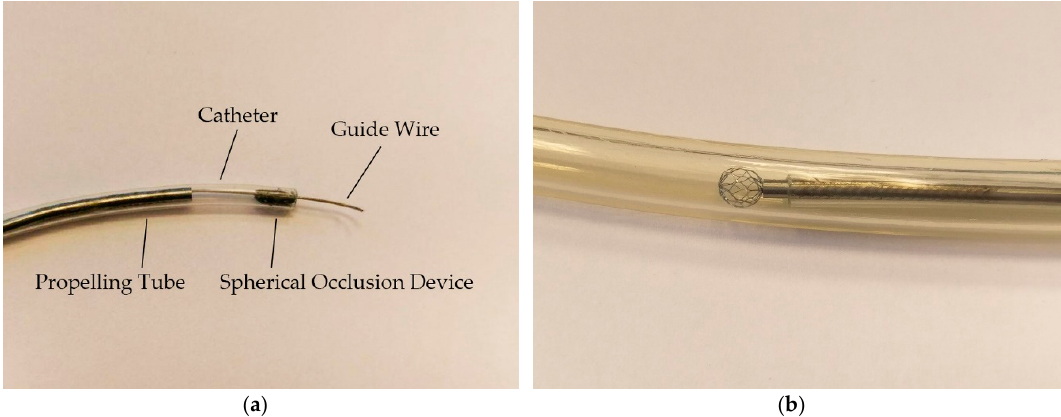
Figure 10. Deployment of spherical occlusion device. ( a ) Spherical occlusion device crimped inside catheter; ( b ) Spherical occlusion device expanded to its full sphere after deployment.